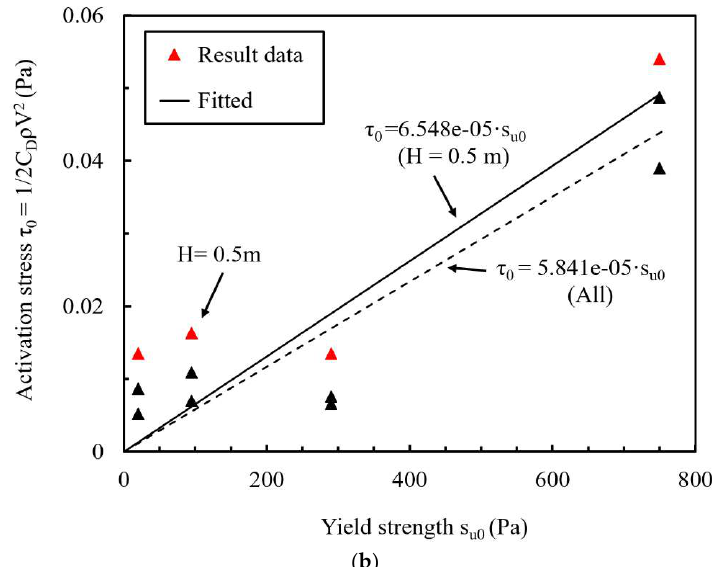
Figure 11. Determination of the activation shear stress. ( a ) Transformation at initial moments; ( b ) Best-fit of the activation shear stress.